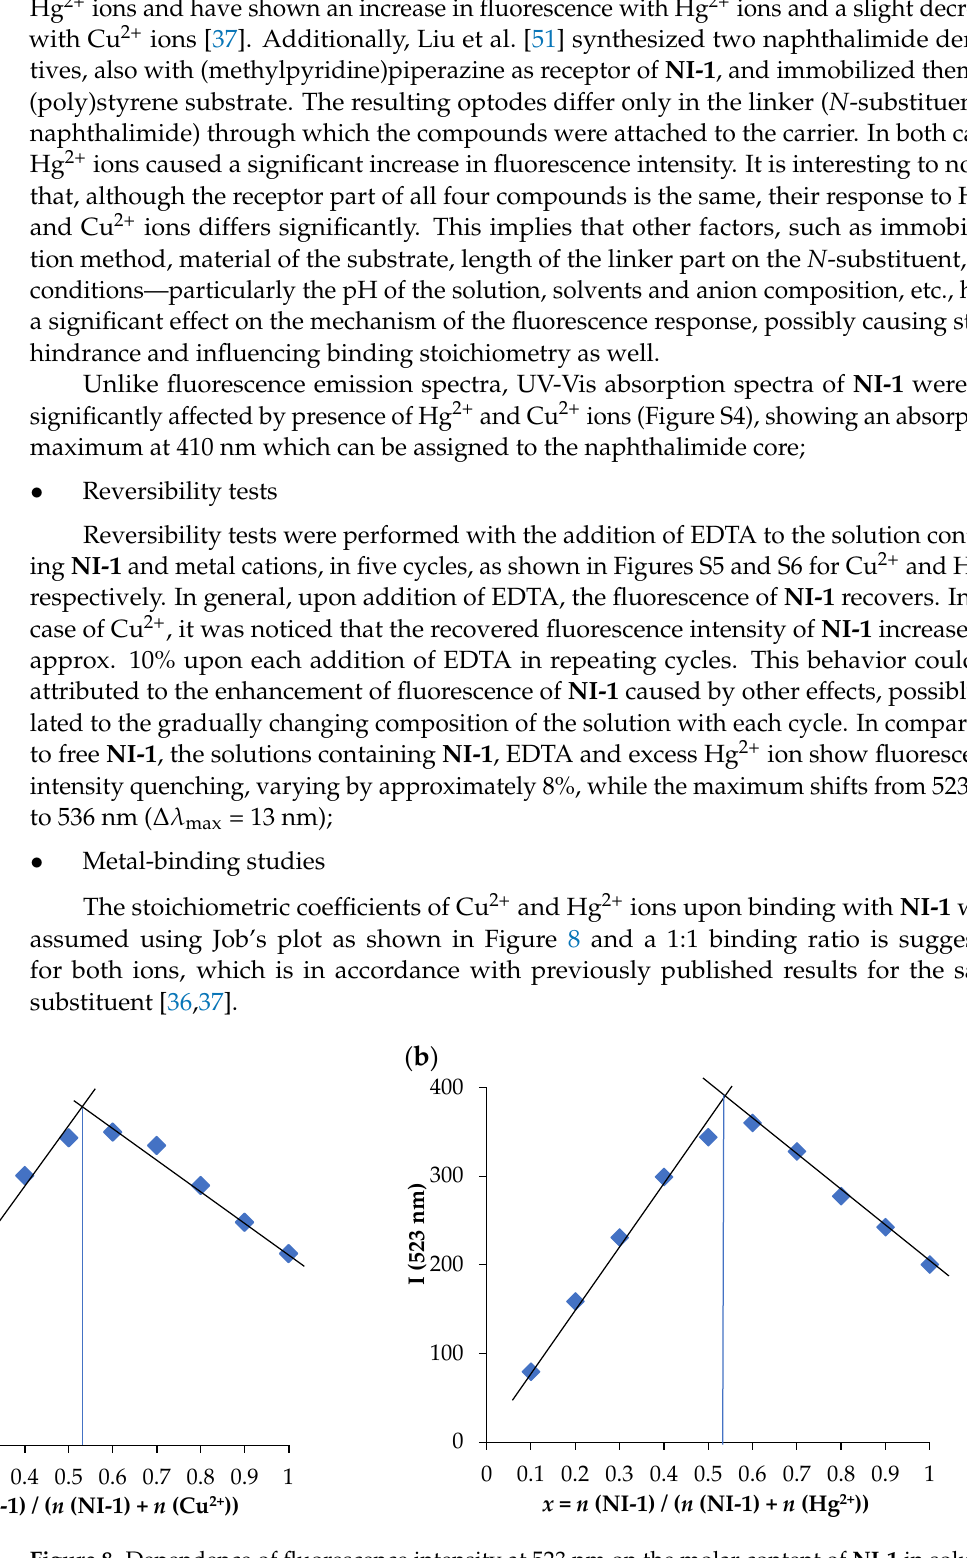
Figure 8. Dependence of fluorescence intensity at 523 nm on the molar content of NI-1 in solution with ( a ) Cu 2+ ions and ( b ) Hg 2+ ions at a total concentration of 5.00 × 10 − 6 M and addition of buffer pH 5.5. The extrapolated directions of intensity dependence on the molar fraction of NI-1 are